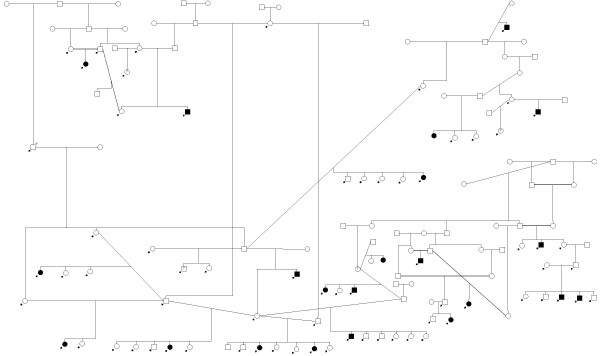
Vizsla linkage family 1 pedigree. Pedigree of Vizsla family 1. Squares and circles represent males and females, respectively. Filled shapes represent cases; those with question marks represent unknown phenotype status. Dogs with arrows were genotyped in this study. The dog marked with an arrow and a + is included on both families 1 & 2, effectively making this one very large family. The Vizsla pedigrees were broken into ten smaller families to decrease inbreeding loops before being analyzed in linkage analysis. Three dogs representing one of the ten sub-families are not shown on either pedigree.